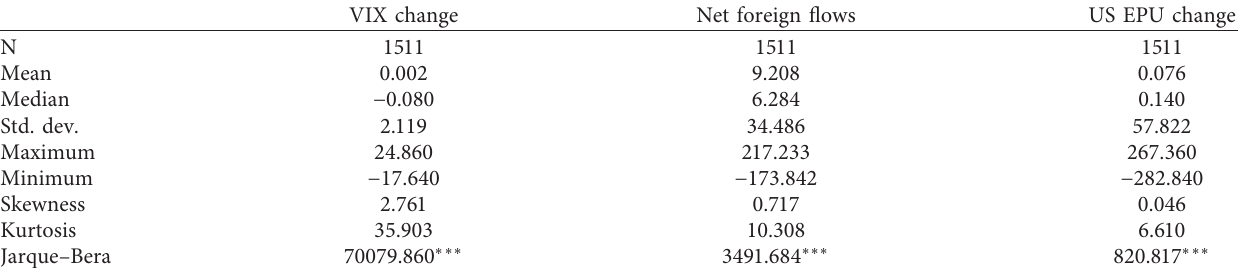
Table 1: Descriptive statistics of net foreign flows in A-share market, the change of VIX index, and US EPU index.